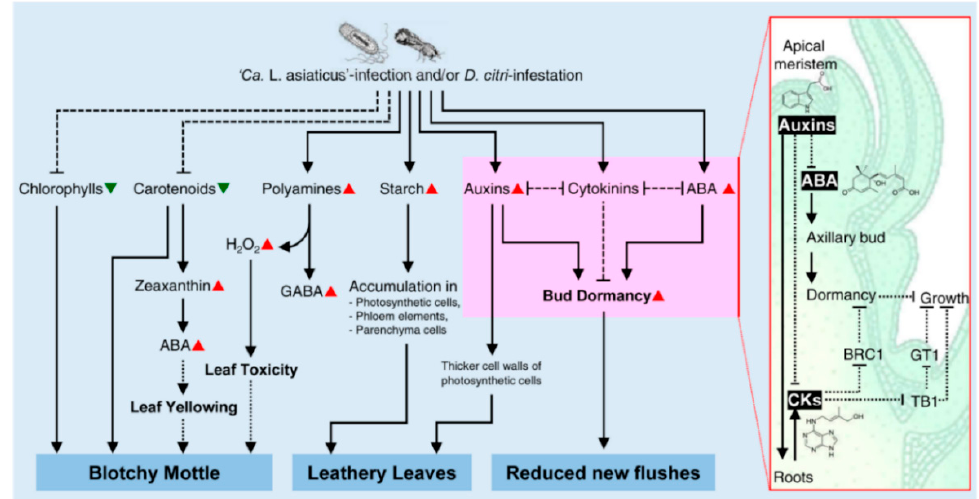
Figure 3. Hypothetical model of the potential roles of citrus metabolites in the development of huanglongbing (HLB) symptoms. Briefly, HLB symptoms are induced by both the pathogen and its vector due to alteration in many physiological aspects such as phytohormones, polyamines, carbohydrate status, and pigment content. The most characteristic symptom of HLB, blotchy mottle, might be due to the degradation of both chlorophylls and carotenoids. Additionally, ABA could induce leaf yellowing, which might help the development of blotchy mottle symptom. Furthermore, polyamines might be involved in HLB symptom development via the production of H 2 O 2 , which may eventually become toxic to the leaf tissue and cause the characteristic blotchy mottle symptom that appears after ‘ Ca . L. asiaticus’ infection. Another characteristic symptom of HLB is the leathery leaves, which could be due to the extensive accumulation of starch grains in the photosynthetic cells, phloem elements, vascular parenchyma, and all other parenchyma cells of the HLB-symptomatic leaves. In addition, we suggest that auxin accumulation in HLB-infected leaves might be involved in the development of leathery leaf symptom via the formation of thicker cell wall in photosynthetic cells. Moreover, it is well-known that ‘ Ca . L. asiaticus’ infection reduces the production of new flushes on infected trees. We believe that the reduced new flushes symptom could be due to the phytohormonal imbalance, particularly the auxin / cytokinin ratio. The solid lines with arrows signify positive reaction, the dashed lines with bar-ends indicate negative correlation, and round-dotted lines represent hypothetical mechanisms or uncharacterized elements, with arrows (positive) or bar-ends (negative). The red triangles signify increased levels, whereas green upside-down triangles signify decreased levels of these compounds upon the infection with ‘ Ca . L. asiaticus’ and / or infestation with D. citri.